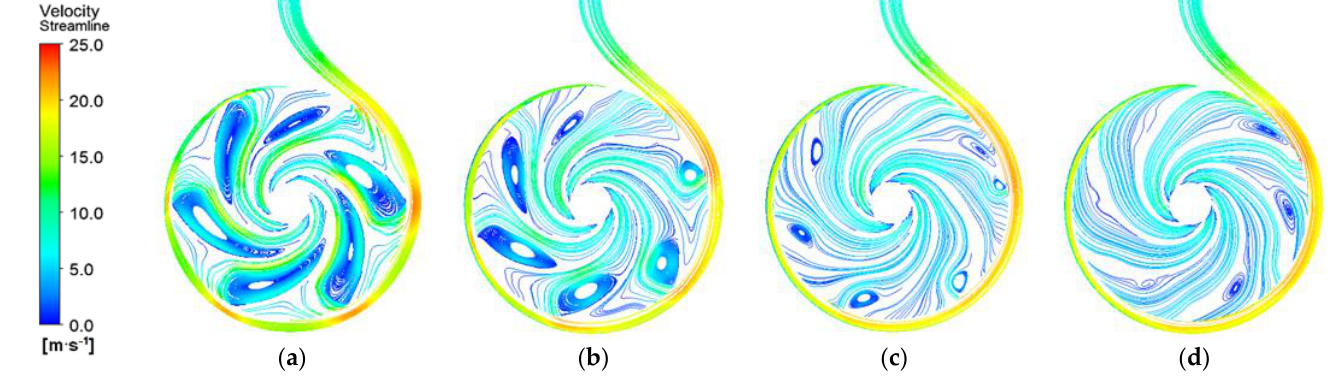
Figure 8. Velocity streamlines distribution of the axial vertical plane at α g = 0.15. ( a ) t = 1 s; ( b ) t = 2 s; ( c ) t = 3 s; ( d ) t = 4 s.